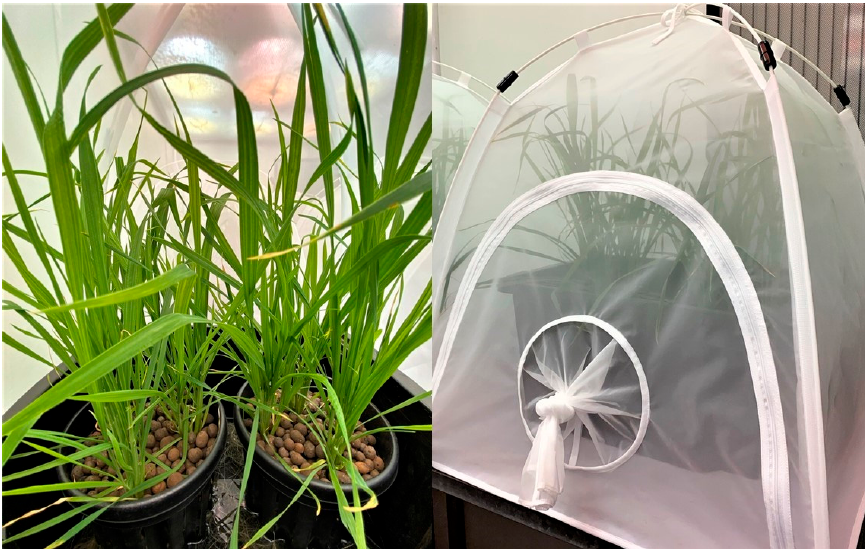
Figure 1. Wheat plants were grown in non-circulating passive hydroponic system ( left ) and contained in insect rearing tents ( right ).